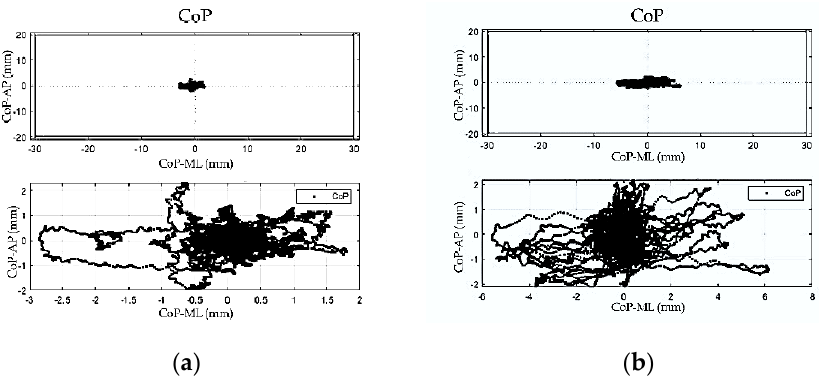
Figure 2. Statokinesigram: displacements of the center of pressure in anterior–posterior and medial–lateral directions during dual tasking: ( a ) good sleep quality group; ( b ) poor sleep quality group ( p > 0.05).